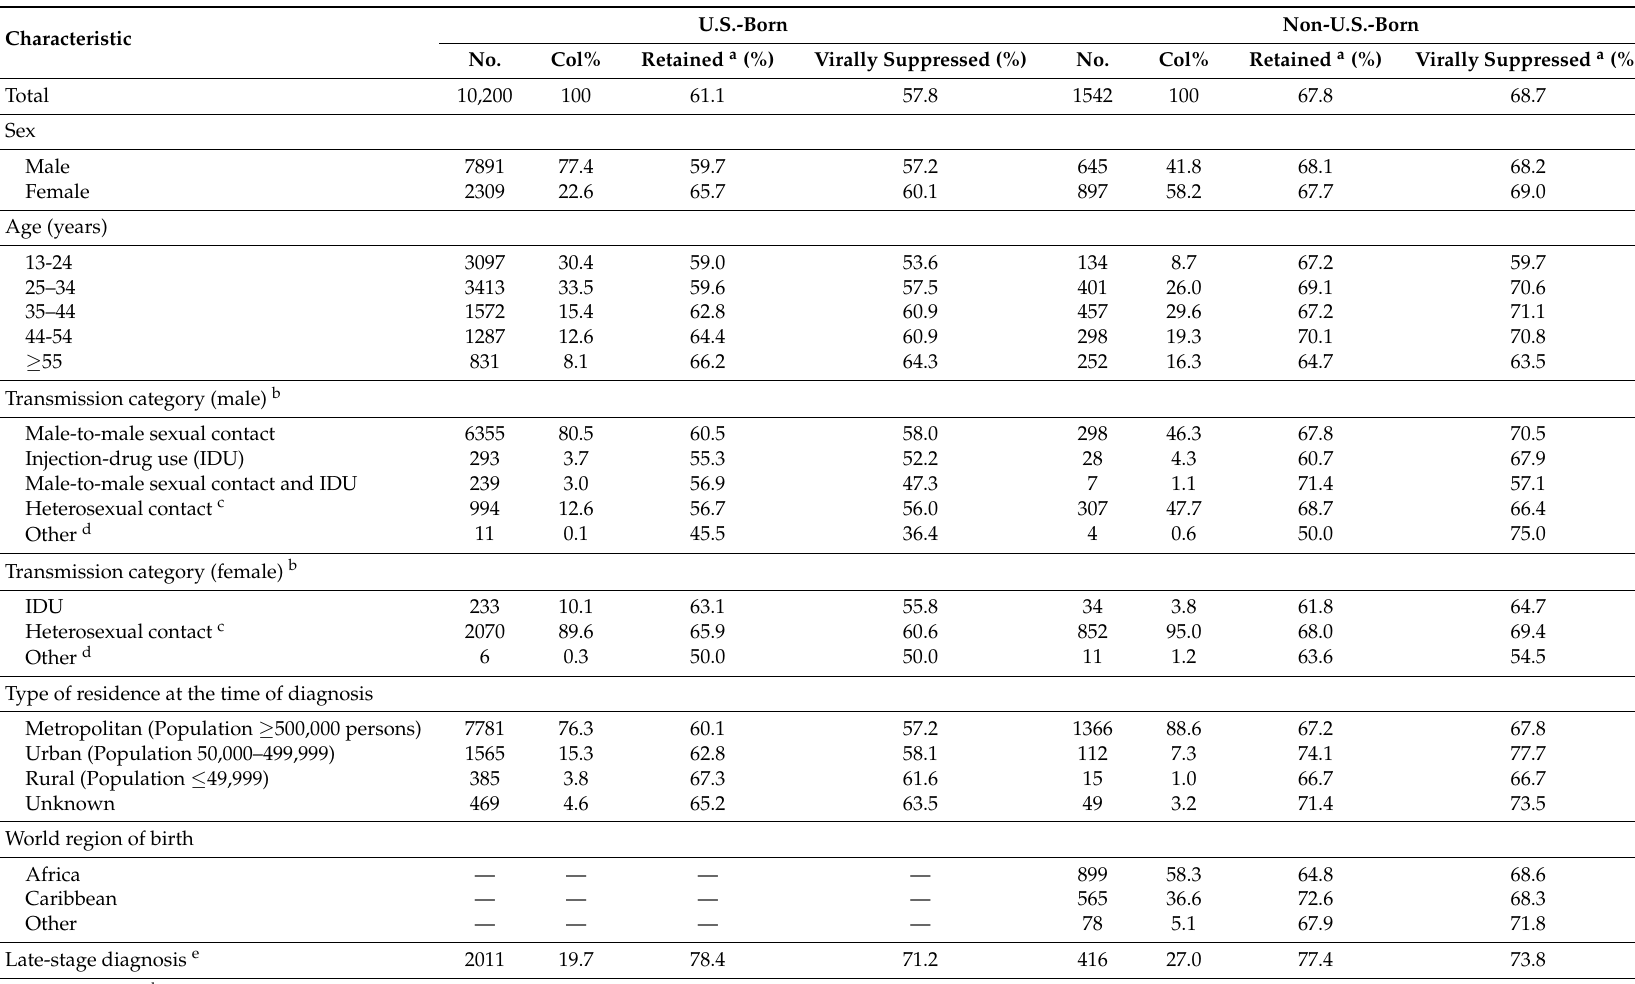
Table 3. Retention in human immunodeficiency virus (HIV) infection-related medical care and viral suppression during 2015, among U.S.-born and non-U.S.-born blacks aged ≥ 13 years, with HIV infection diagnosed during 2014 and who were alive at end-of-year 2015, by selected demographic characteristics, National HIV Surveillance System, 40 U.S.